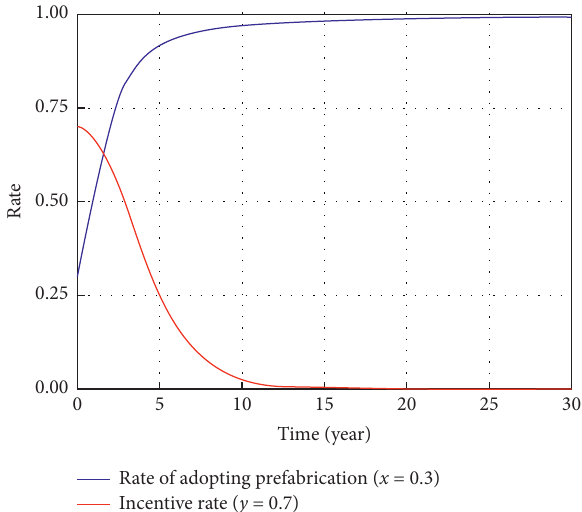
Figure 8: Simulation results of dynamic incentive strategies under the initial strategy ( x � 0 . 3 , y � 0 . 7).